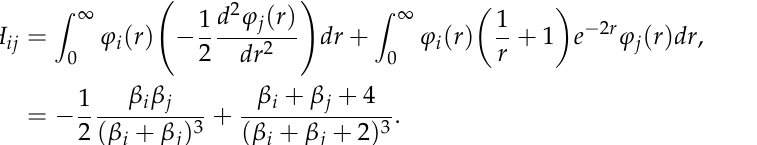
Figure 2. Red circles: values of n = 1, 2, . . . plotted against ln E obtained using cubic-spline interpolation between the free-particle eigenvalue data. Yellow circles: the points on the interpolated curve for the positron energies E n in the static hydrogen potential. From this, it can be seen that ln E n corresponds to non-integer ordinates n − δ / π